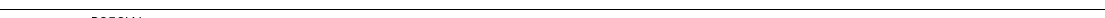
Fig. 3 Nlrp3 R258W mice carry a unique gut microbiota with a sparingly inerconnected ecology and altered functionality. a – f Fecal microbiota composition was assayed by bacterial 16S rRNA V3 – V4 region sequencing: a PCoA plot (based on Bray – Curtis distance) of the gut microbiota from three trials of WT ( n = 18, 9, and 18) and Nlrp3 R258W ( n = 18, 5, and 15) mice. b Redundancy analysis ordination biplot based on the Hellinger-transformed Euclidean distance among samples and the eigenvalues for 50 OTUs (which explained more than 10% of the variability of the samples). c Heat map of the 50 key OTUs in gut microbiota from WT and Nlrp3 R258W mice at the age of 8, 9, and 10 weeks in trials 1 – 3. d The WT indices of the gut microbiota from WT and Nlrp3 R258W mice at the age of 8 and 10 weeks in trials 1 – 3. The medians with interquartile ranges are shown. *** P < 0.001 (Mann – Whitney test). e The area under the ROC curve (AUC) of the gut – microbiota-based classi fi cation of the WT and Nlrp3 R258W mice. The WT-index was computed for another set of WT ( n = 12) and Nlrp3 R258W ( n = 15) samples (trial 4). f The network of OTUs (shared by more than 40% of samples) in the WT (+/+) and Nlrp3 R258W (+/R258W) mice during DSS treatment ( n = 6 from day − 20 to day 2 and n = 4 on days 3 and 8). The lines represent positive (red) and negative (blue) correlations between the nodes, with the line width indicating the correlation magnitude. Only nodes with | R | > 0.7 are drawn, and unconnected nodes have been omitted. g Metagenomic analysis of key pathways of gut microbiota shift in Nlrp3 R258W mice. Histogram shows the LDA scores computed for features (on the pathway level) that are differentially abundant between the WT and Nlrp3 R258W